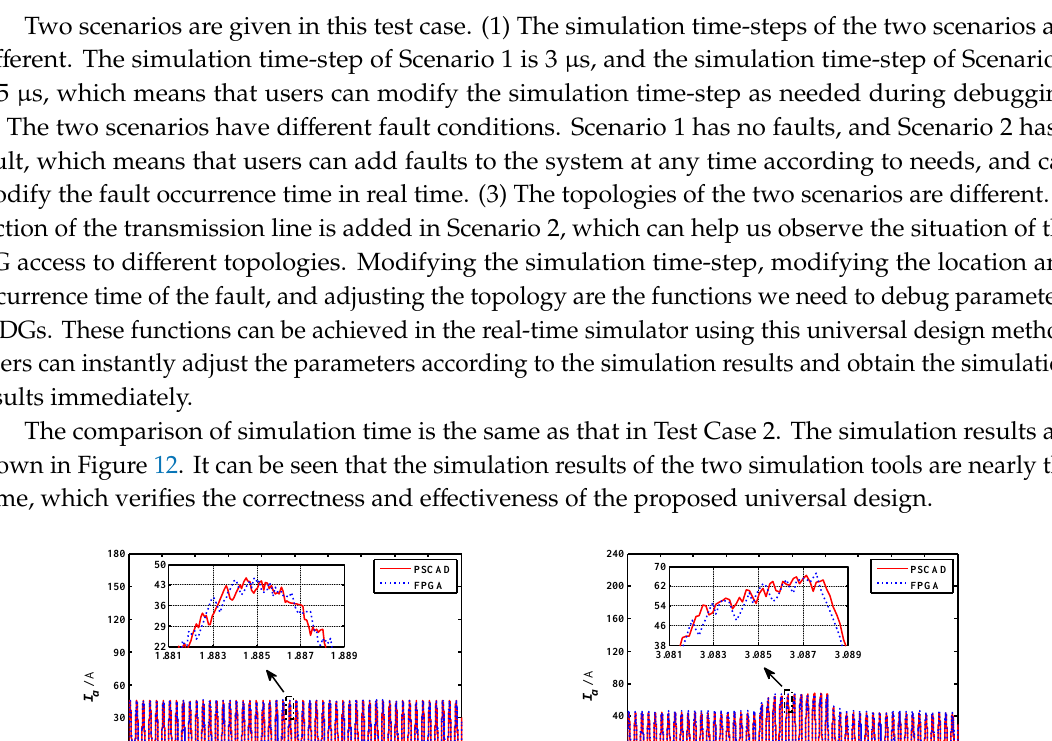
Figure 11. Test cases of the PV. ( a ) Scenario 1: The PV connected with the infinite bus system. ( b ) Scenario 2: The PV connected with the infinite bus system via a section of the transmission line.